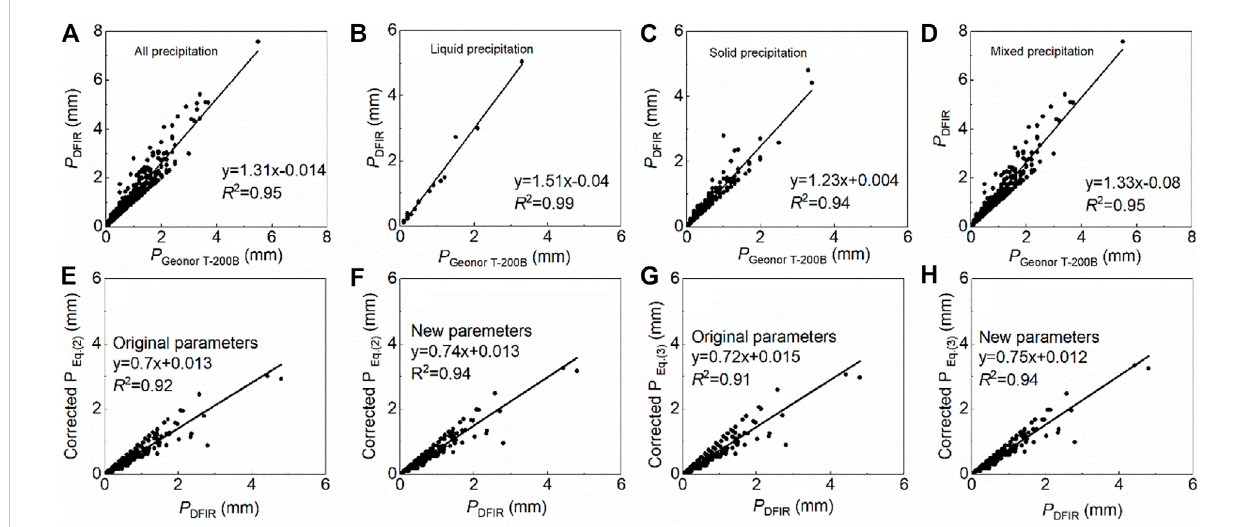
FIGURE 4 ComparisonoftheprecipitationamountobservedfromGeonorT-200BandderivedfromtheDFIRforprecipitation (A) ,liquidprecipitation (B) ,solid precipitation (C) , and mixed precipitation (D) before correction and the comparison between the DFIR and adjusted solid precipitation with original parameters (E , G) using Eqs 2, 3 and new parameters (F , H) .